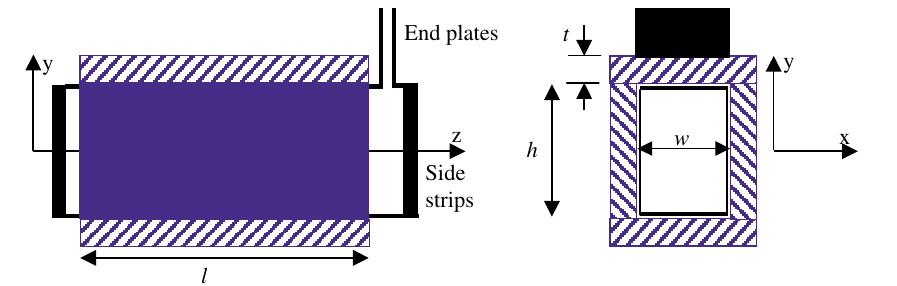
FIG. 3. (Color) Schematic view of a window frame kicker. Crosshatched (blue) frames represent ferrite blocks. z is the beam axis. h is the aperture height, w is the width, l is the busbar length, and t is the ferrite